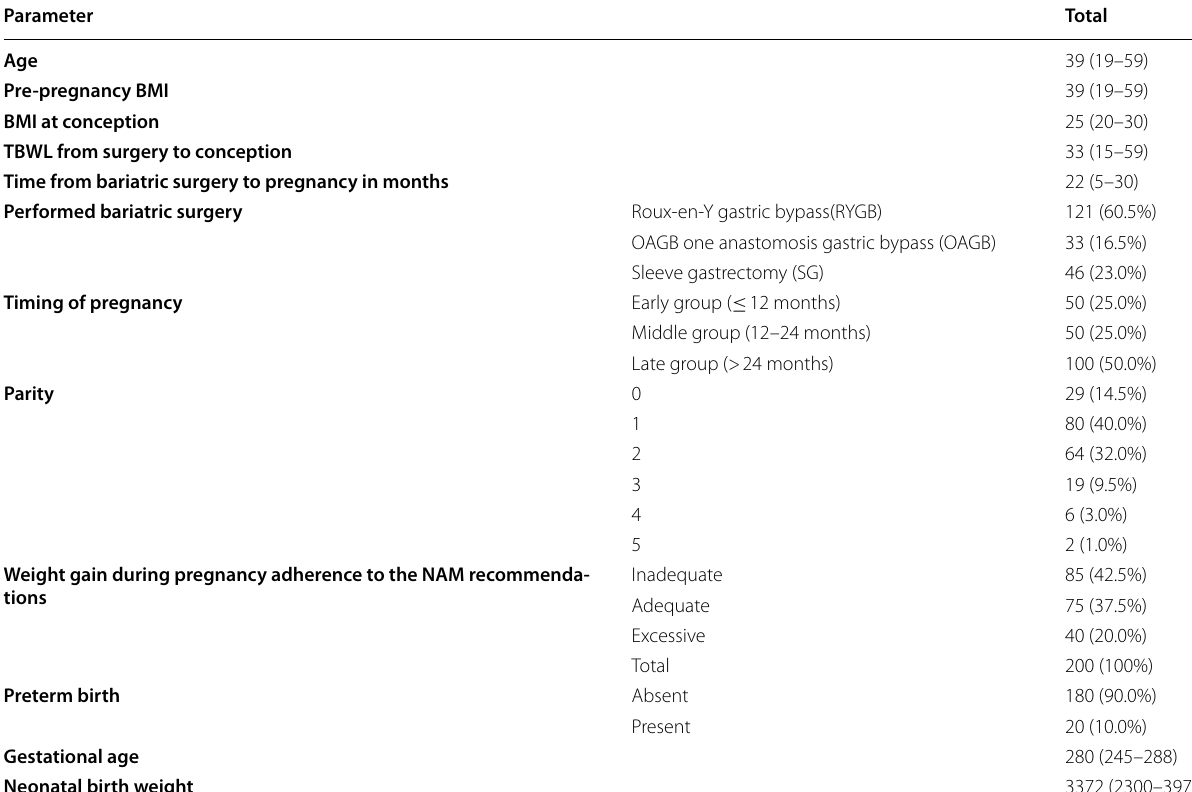
Variables expressed by median (range) or n (%) as